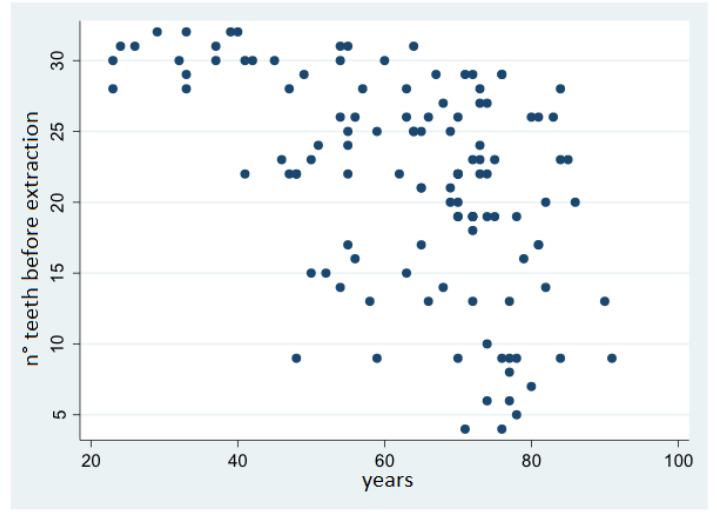
Figure 2. Correlation between age and number of teeth before extraction.